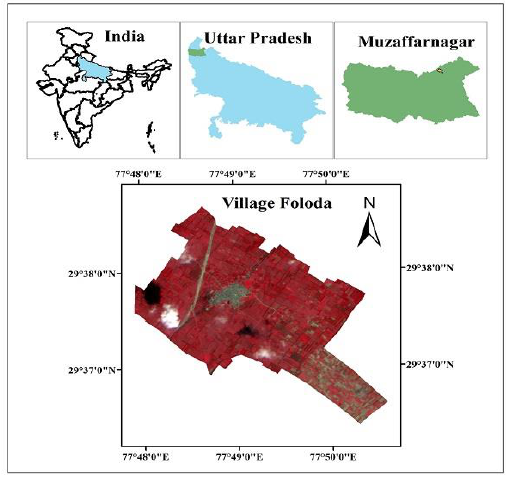
Figure 1. The study area